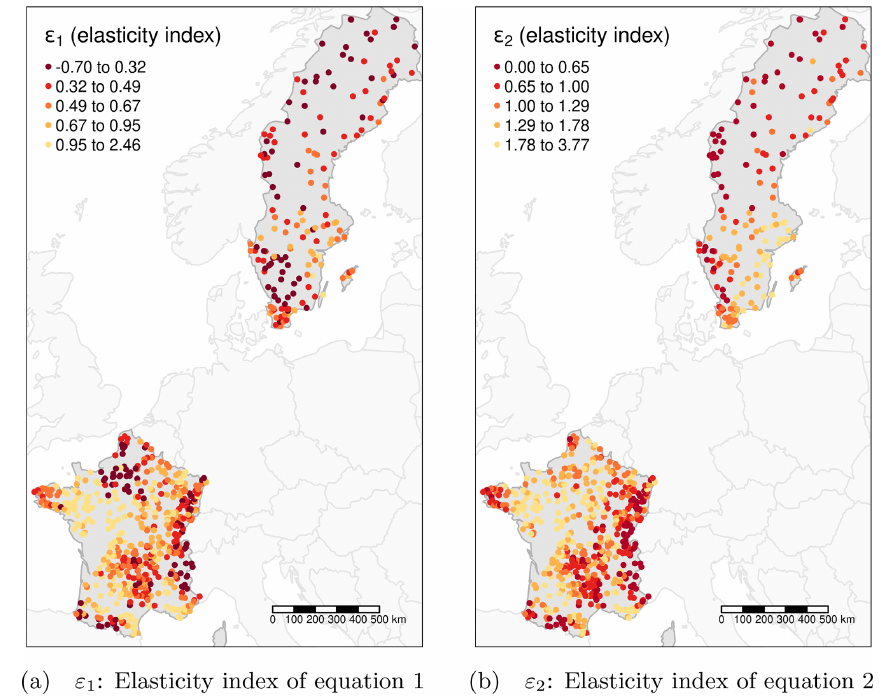
Figure 9. Comparison of elasticity index values obtained by optimizing Eq. (1) (which does not account for memory effects) and Eq. (2) (which does account for memory effects). The classes are delimited by quantile values to make a relative comparison of spatial patterns